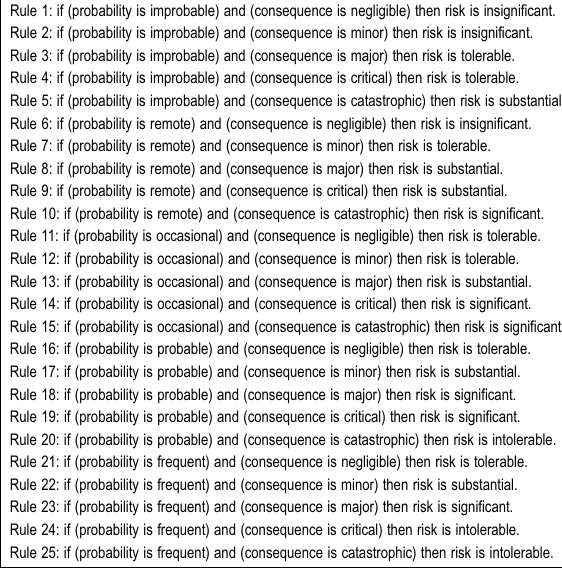
Fig. 8. List of the fuzzy if-then